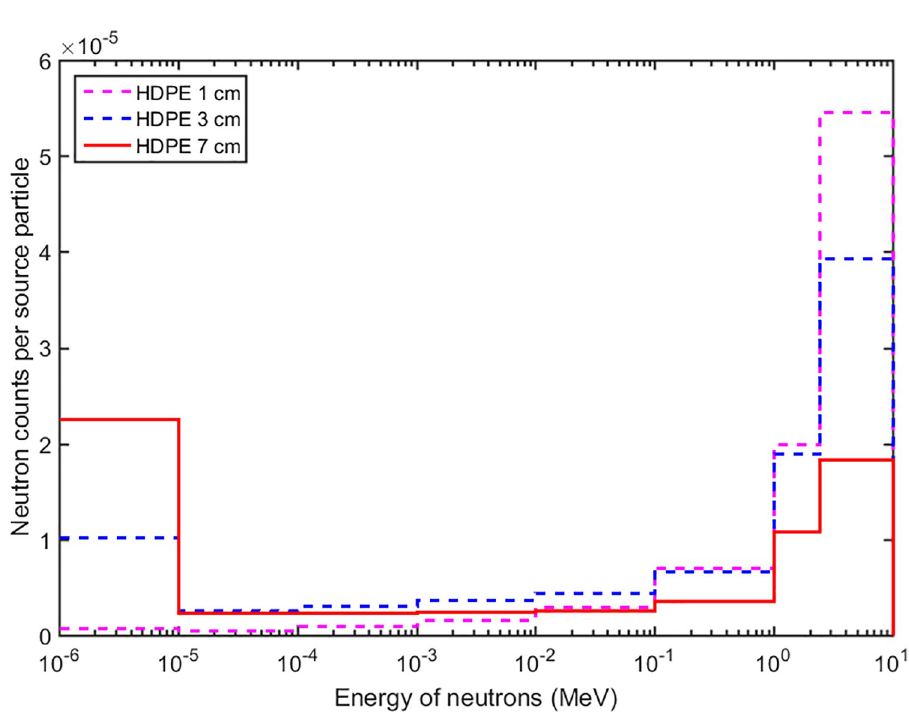
Fig 6. The energy distributions of neutrons with different thicknesses of HDPE increase.